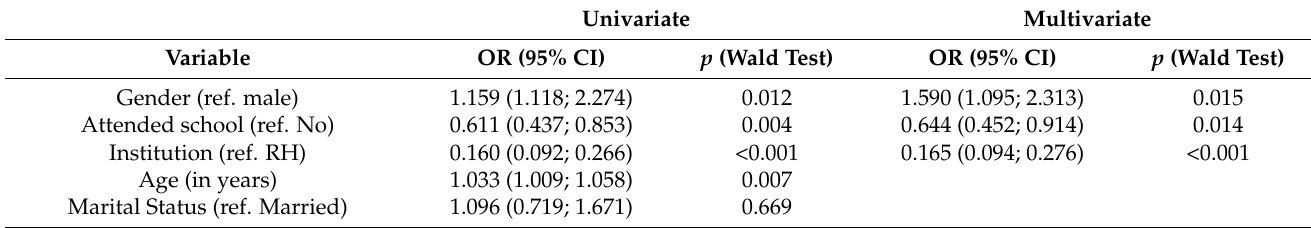
Table 5. Univariate and multivariate logistic models for moderate, severe or complete functional problem (total ENCS > 2). Univariate